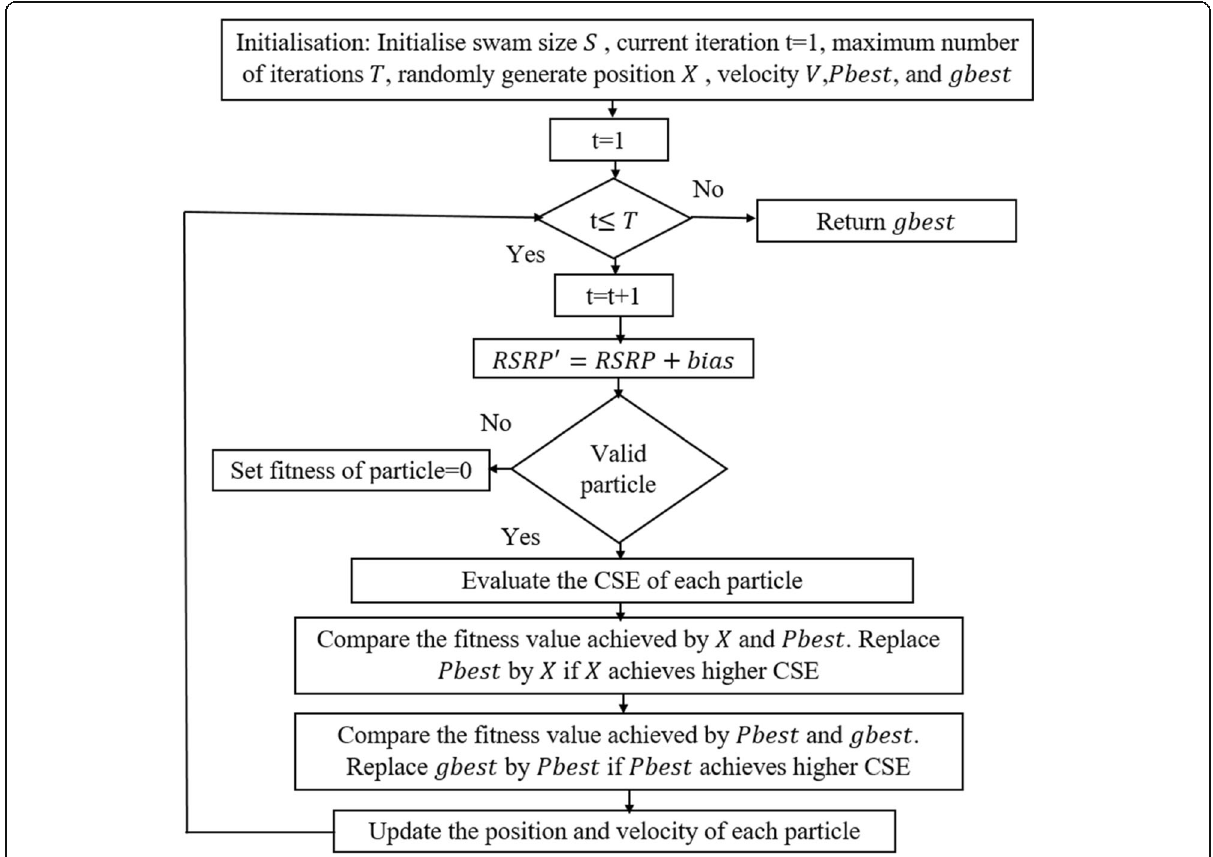
Fig. 2 The PSO process to generate dynamic biasing per-BS. This figure describes how particle swarm optimisation can be applied to generate per base station biasing. It first generates the particles, checks the validity and fitness of each particle and it records the best achievable particle is in the swarm so far. PSO keeps repeating this process until the maximum number of iterations is reached